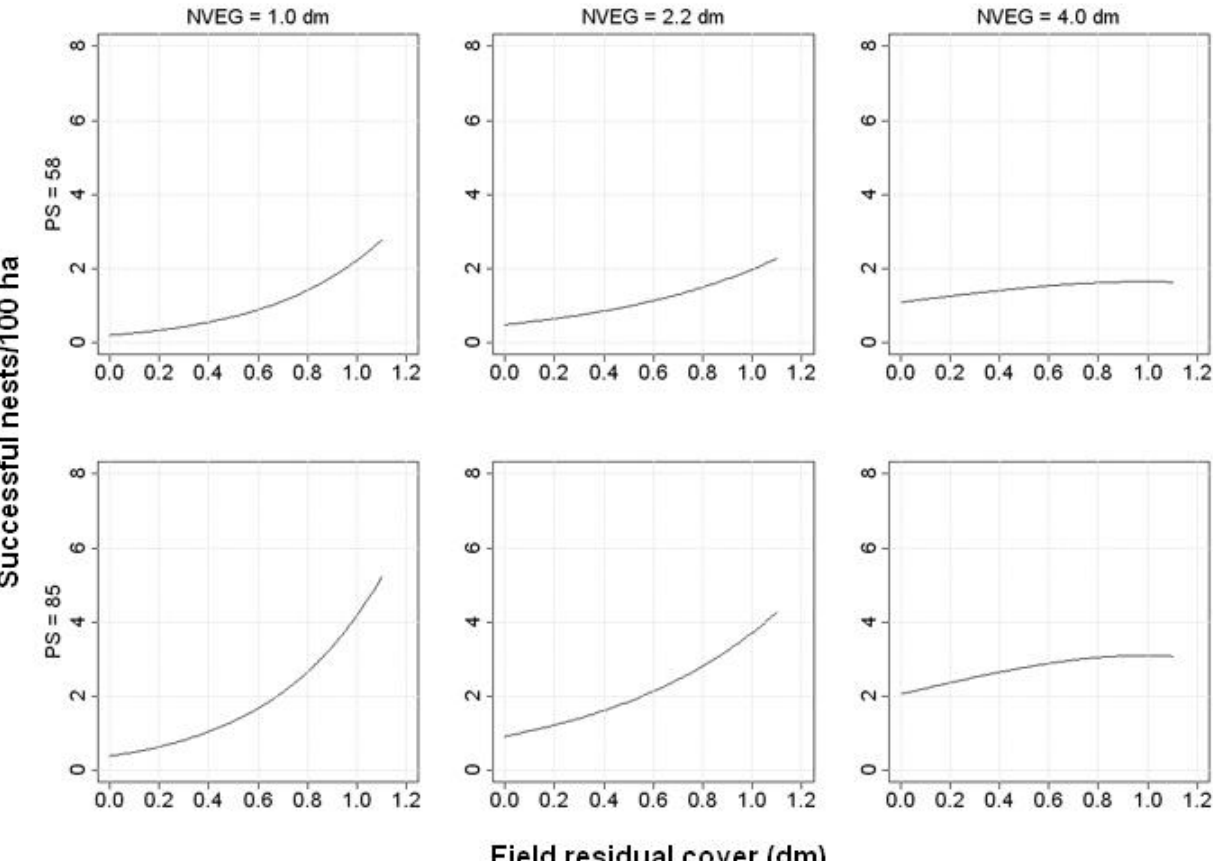
Fig. 4 . Predicted duck production (successful nests/100 ha) in the Aspen Parkland of Alberta, Canada, in relation to nest-site vegetation density (NVEG), field residual cover, and pasture health score (PS), based on the product of the most parsimonious nest density and nesting success models ( n = 100 fields and 633 nest-fate intervals, respectively). The covariates residual cover (RC) and PS are correlated across all values (Pearson’s product-moment correlation, r = 0.46, P < 0.01), but the correlation is nonsignificant at PS > 57 ( r = 0.19, P = 0.191). The PS values graphed therefore represent the point at which RC and PS no longer demonstrate a correlation (58), and the 90% quantile (85). Values